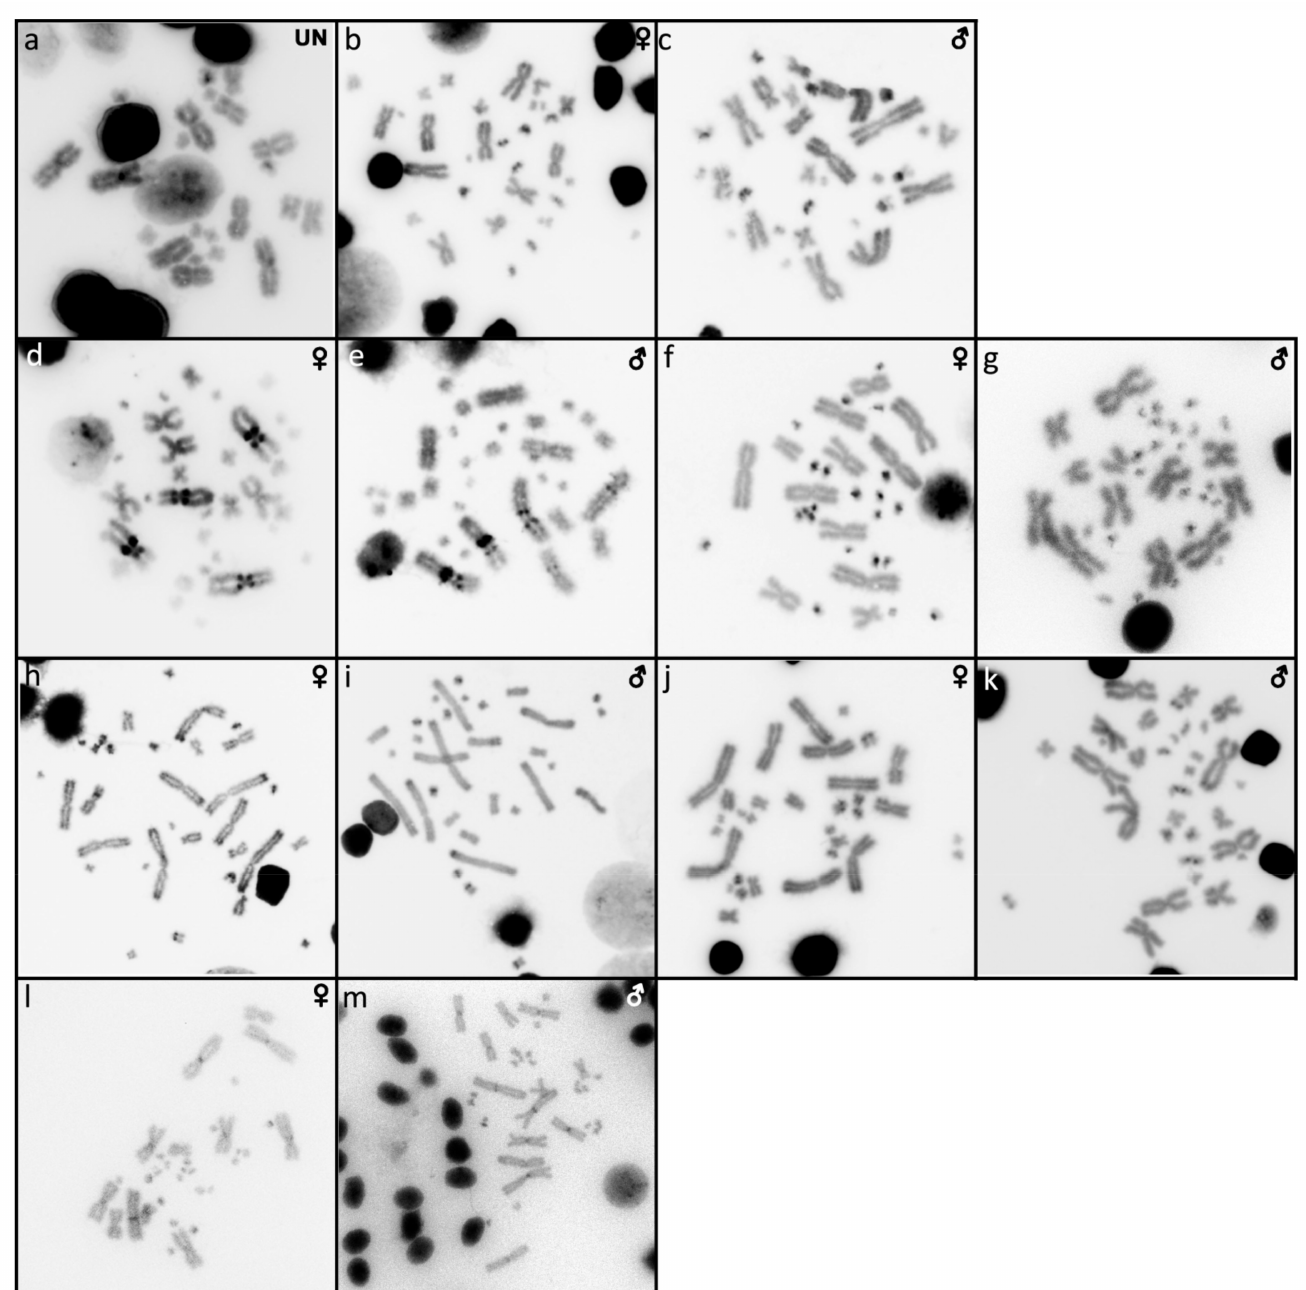
Figure 2. C-banded metaphases of Acontias percivali ( a ), Cyclodomorphus gerrardii ( b , c ), Eutropis multifasciata ( d , e ), Platysaurus sp. 1 ( f ), Platysaurus sp. 2 ( g ), Tiliqua gigas ( h , i ), Tiliqua scincoides ( j , k ), and Tracheloptychus madagascariensis ( l , m ). UN: sex not